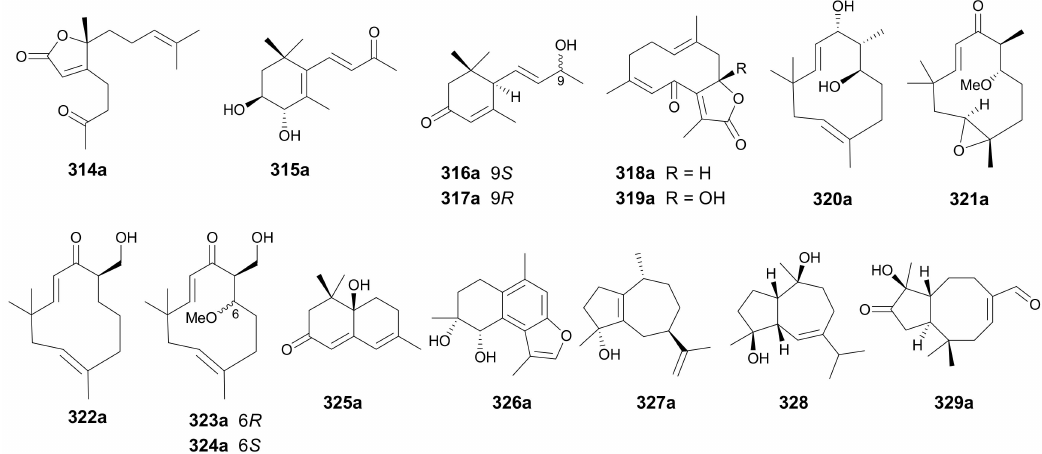
Figure 18. Structures of sesquiterpenoids.